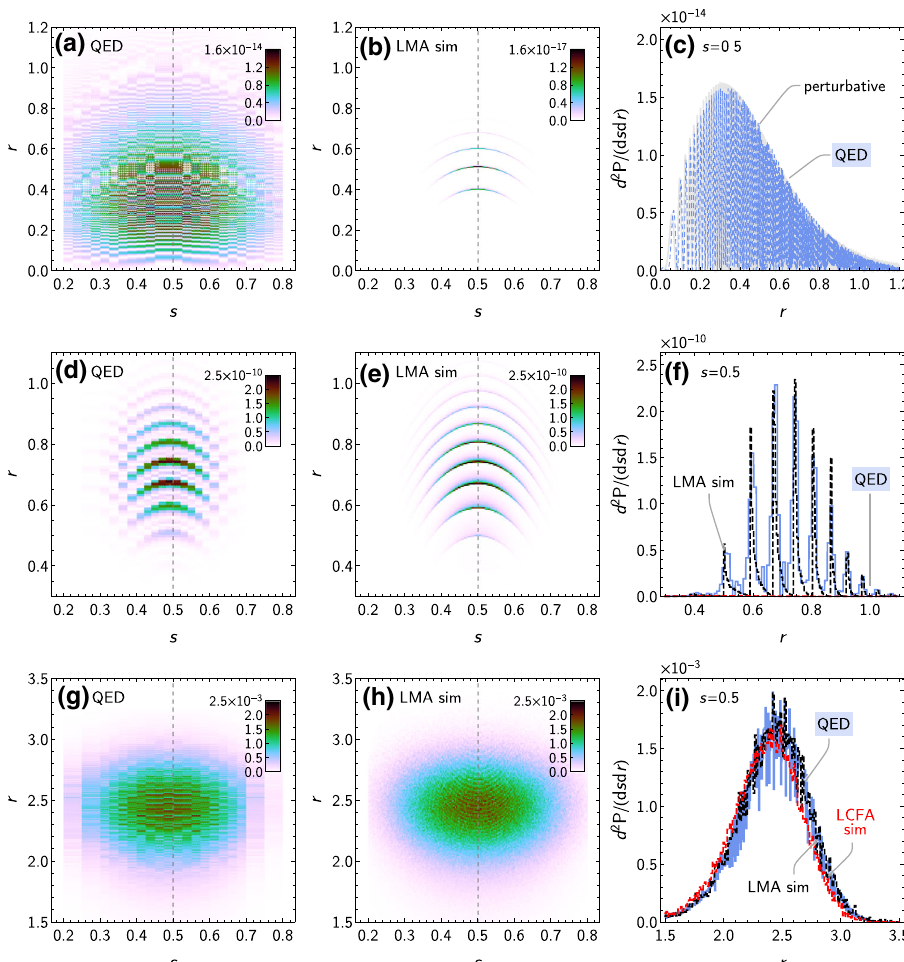
Fig. 8 Double-differential spectra (lightfront momentum s and scaled perpendicular momentum q ⊥ ) for positrons produced by a photon with energy parameter η in a laser pulse with peak amplitude ξ = 0 . 2 (top row), ξ = 0 . 5 (middle row), ξ = 2 . 5 (bottom row). Left column: QED results. Centre column: simulation results. Right column: Lineouts at s = 0 .